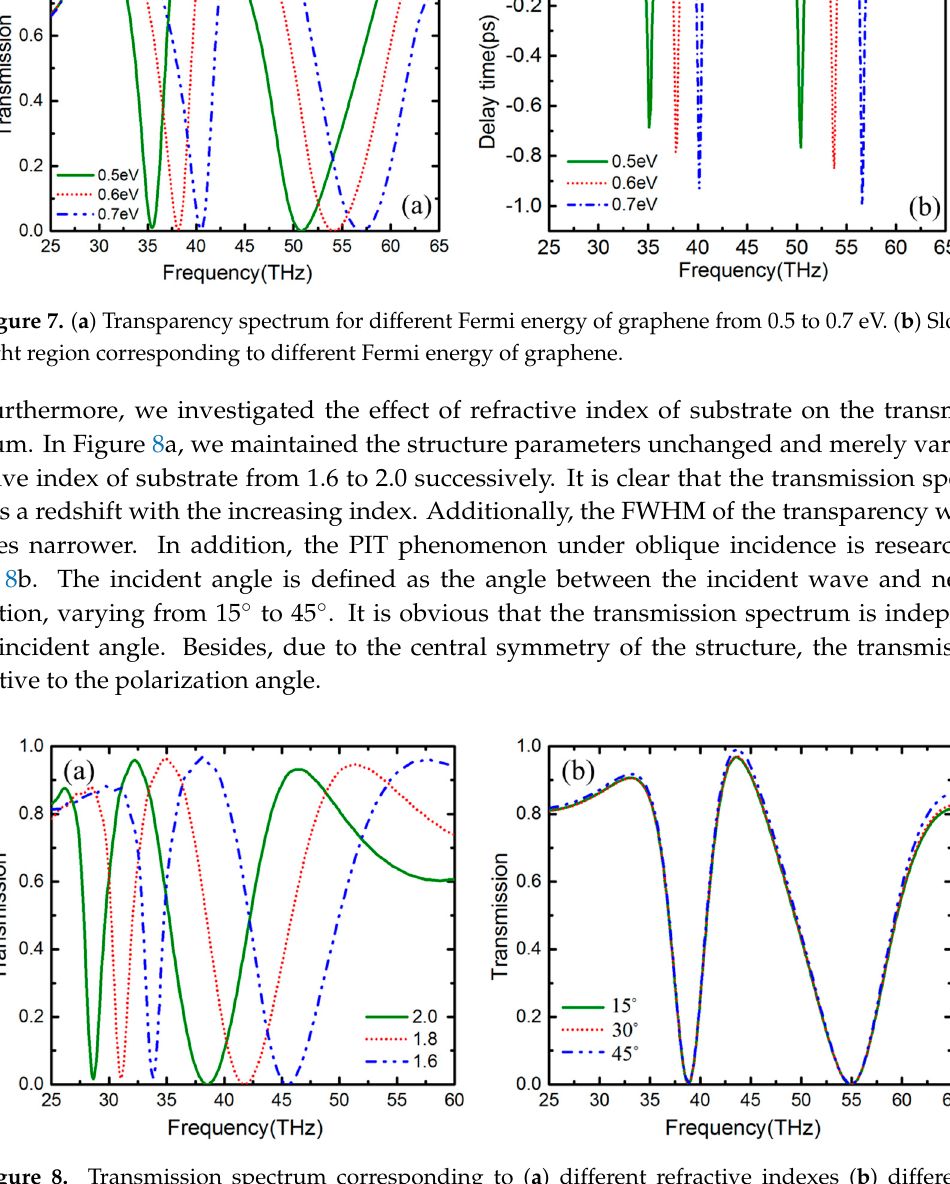
Figure 8. Transmission spectrum corresponding to ( a ) different refractive indexes ( b ) different incident angles.